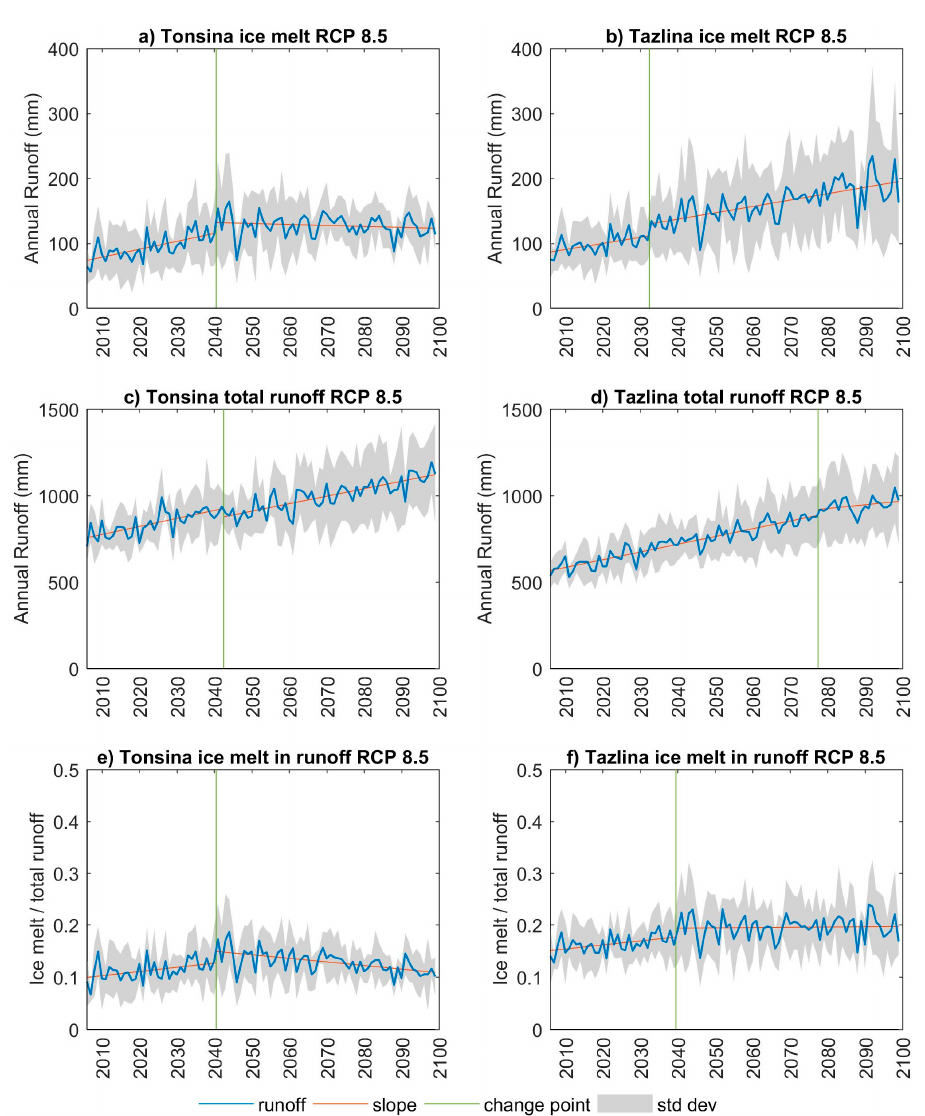
Figure 10. Trends in runoff from glacier ice melt ( a , b ), total runoff ( c , d ), and the ratio of ice melt to total runoff in two glacier-fed tributaries in the Chugach Mountains: the Tonsina River gage (left column) and the Tazlina River gage (right column). Results displayed are based on RCP 8.5 five-model mean (MM85), with the standard deviation of individual CMIP5 models shown in gray. In scenario RCP 4.5 (not shown) ice melt from both glaciers stops increasing in mid-Century.